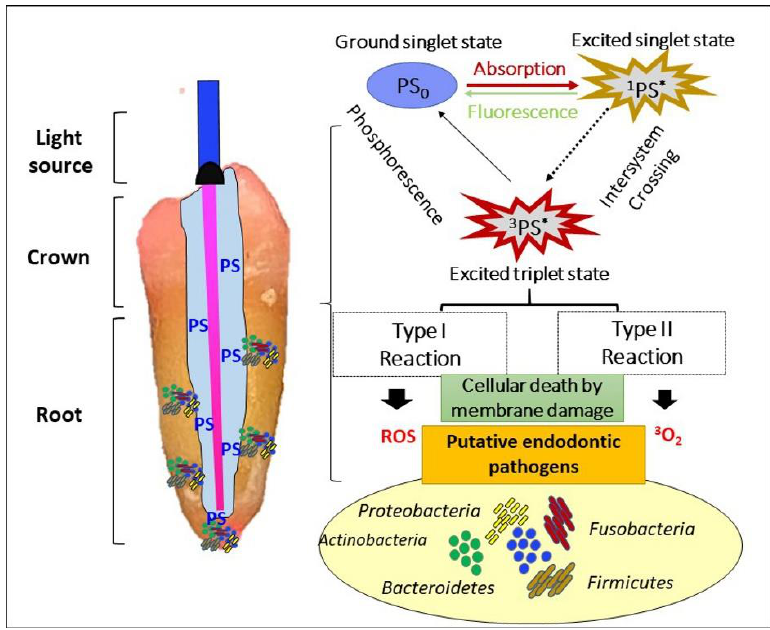
Figure 2. A light source with a specific wavelength can activate a photosensitizer to an excited singlet state and then to a triplet singlet state in antimicrobial photodynamic therapy. The triplet singlet state can induce antimicrobial killing via the generation of the reactive oxygen species (Type I), singlet oxygen (Type II), or both.